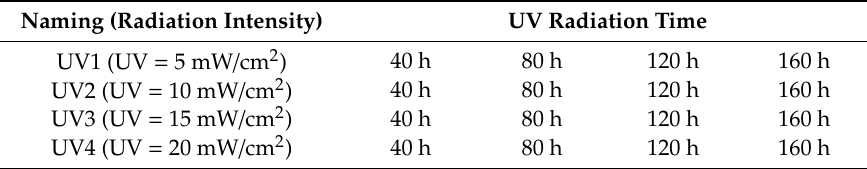
Table 2. UV radiation tests